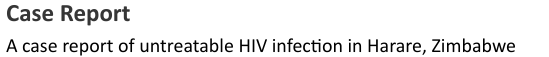
A case report of untreatable HIV infection in Harare, Zimbabwe Cleophas Chimbetete, Linda Chirimuta, Margaret Pascoe, Olivia Keiser